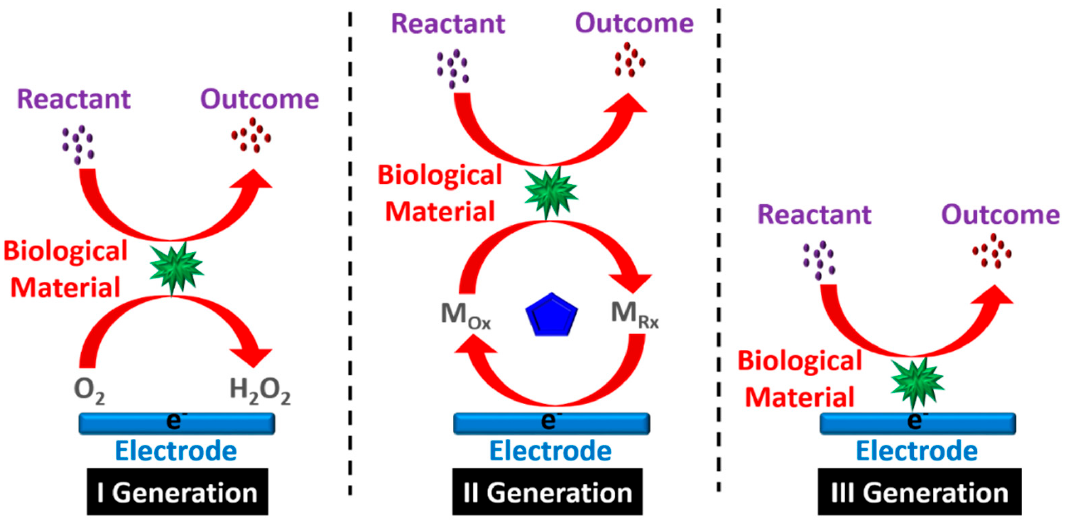
Figure 1. Three generations of the biosensor process. Table 1. Evolution of the development of biosensors.